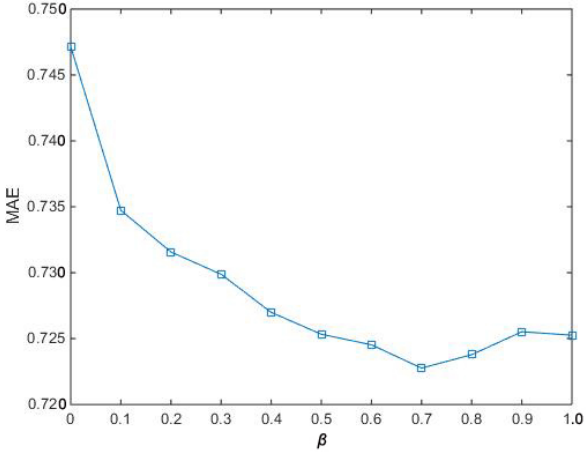
Fig. 2 Effect of parameter ˛˛˛ on MAE values of TT-ItemCF